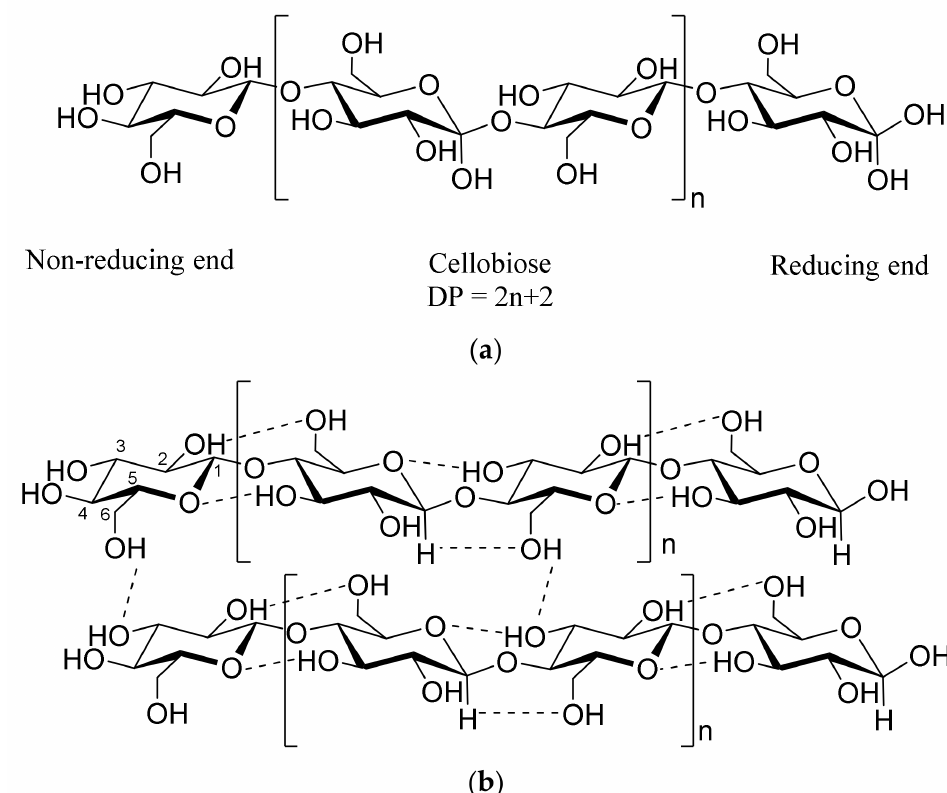
Figure 1. Chemical structure and hydrogen bonding in cellulose: ( a ) basic chemical structure of a cellulose chain; ( b ) intra- and interchain hydrogen bonding in